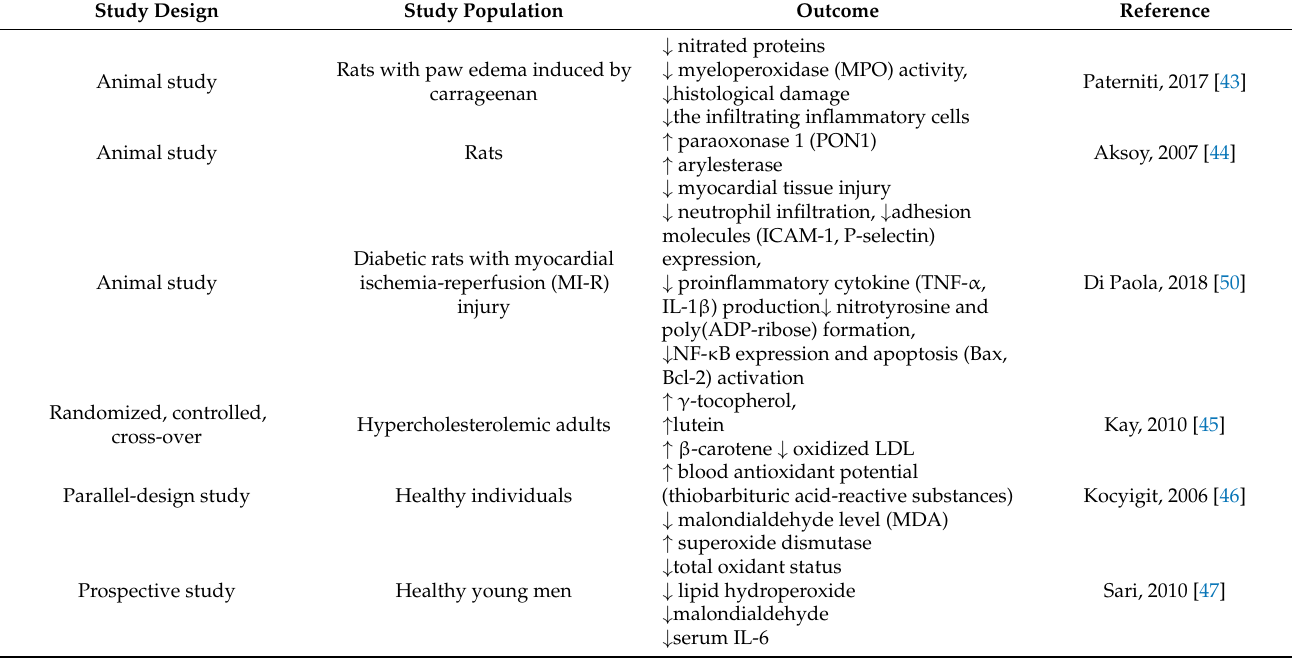
Table 4. Antioxidant and anti-inflammatory effects related to pistachio